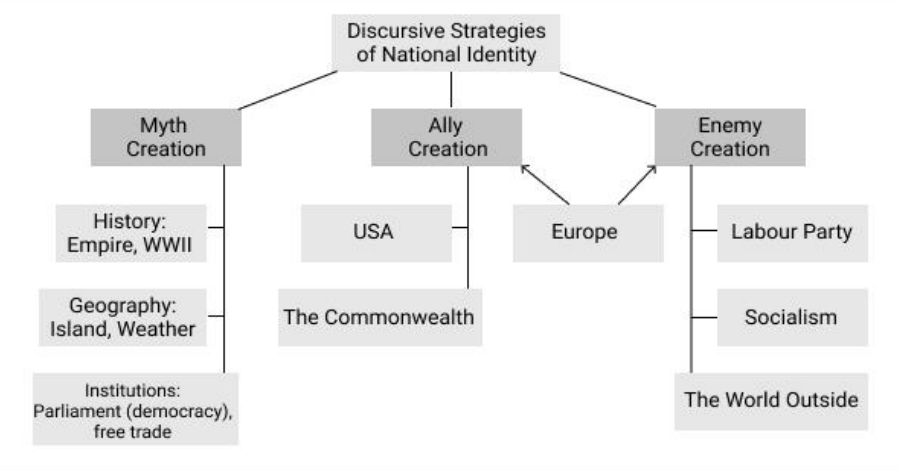
Figure 1. Discursive Strategies of National Identity.